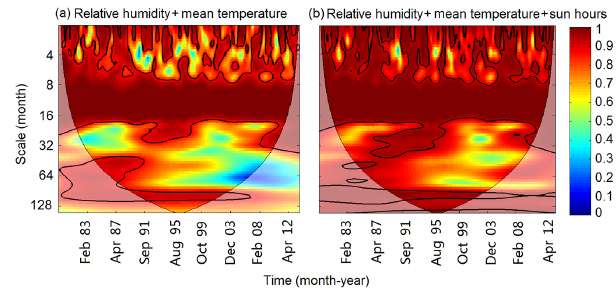
Figure 7. Multiple wavelet coherence between evaporation ( E ) from water surfaces and meteorological factors, such as (a) rela- tive humidity and mean temperature and (b) relative humidity, mean temperature, and sun hours, at the Changwu site in Shaanxi,